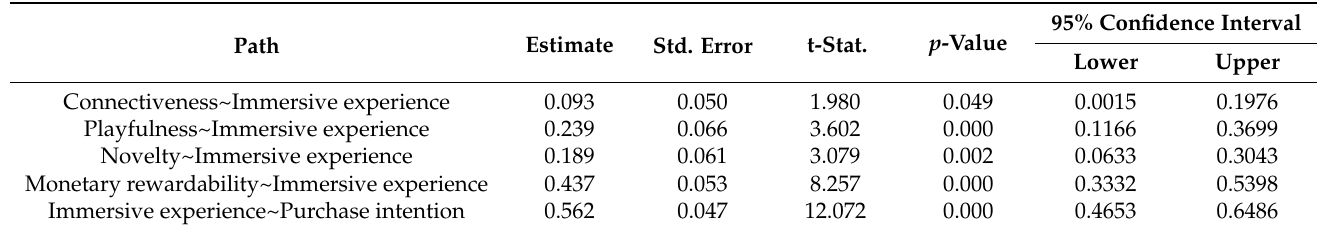
Table 1. Estimated path coefficients.